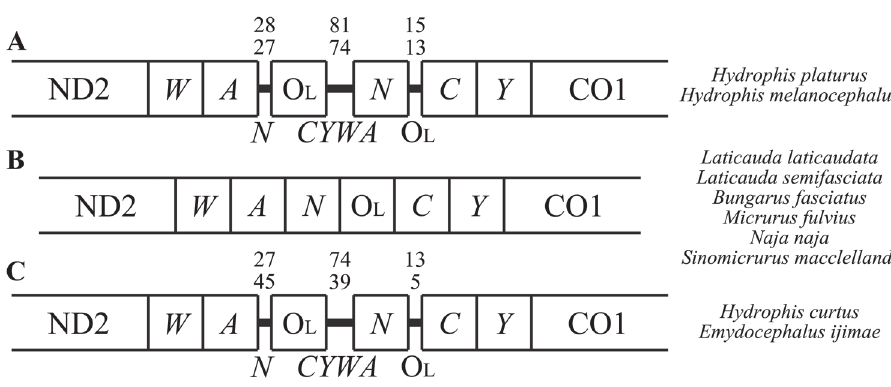
Figure 4. Intergenic spacers located in the cluster of five tRNA genes ( WANCY gene region) of two sea snake species ( Hydrophis platurus and H. melanocephalus ) found off South Korean coastal waters A intergenic spacers located in the WANCY gene region of two sea krait species ( Laticauda laticaudata and L. semifasciata ), four terrestrial cobras ( Bungarus fasciatus , Micrurus fulvius , Naja naja and Sinomicrurus macclellandi ) B and two true sea snake species downloaded from GenBank ( H. curtus and Emydocephalus ijimae ) C intergenic spacer lengths amongst Hydrophiinae species are above the intergenic spacer in the same order as the species are listed. The hypothesised tRNA genes lost due to random deletions are written below the intergenic spacers. The tRNA genes are abbreviated by the corresponding one-letter amino acid codes, such as W , A , N